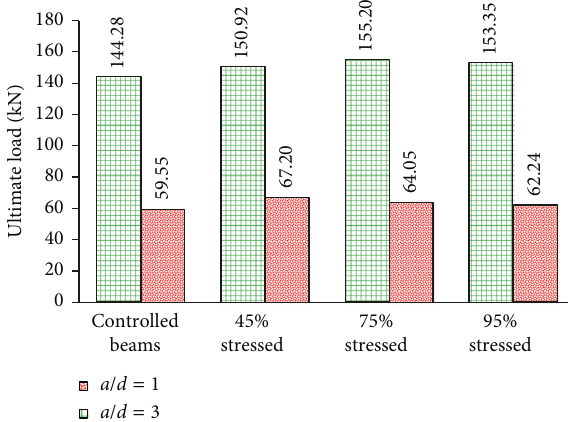
Figure 9: Comparison of ultimate loads of shear-deficient beams tested at a / d ratios 1 and 3.